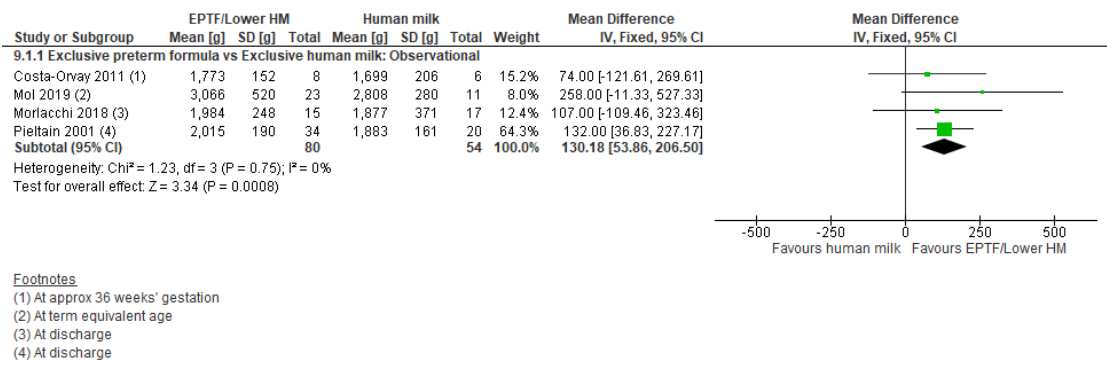
Figure 8. Forest plot of mean difference in change in % fat-free mass and human milk intake.